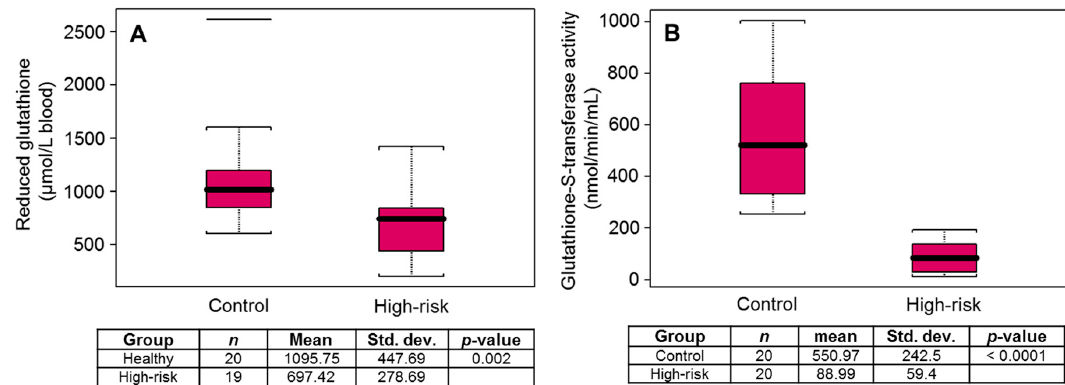
Figure 2. Box plot for ( A ) reduced glutathione levels, and ( B ) glutathione S-transferase activity in healthy controls and high-risk subjects for prostate cancer. Black bar = median, red box = 25th to 75th percentiles, Bars = entire range. The horizontal lines beyond the bars are outliers or whiskers are drawn individually.